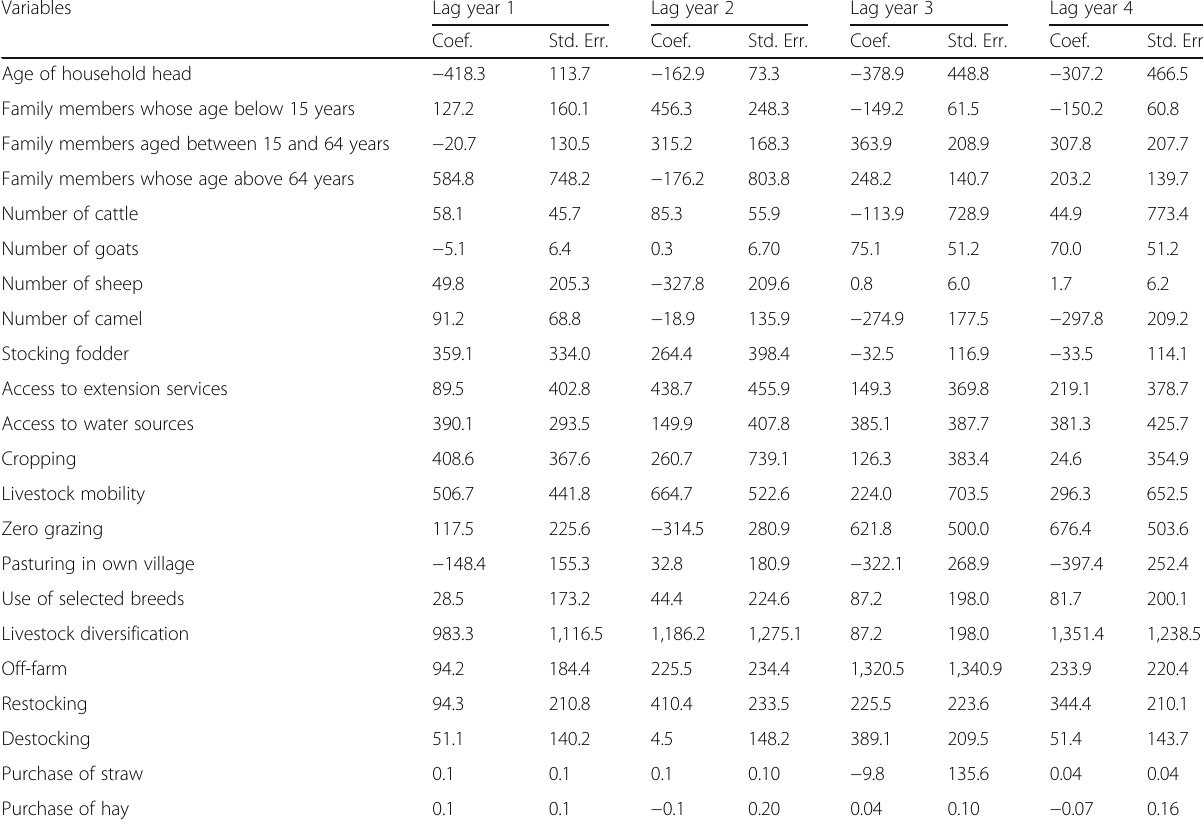
Table 8 Regression outputs of dynamic fixed effects model against the dependent variable